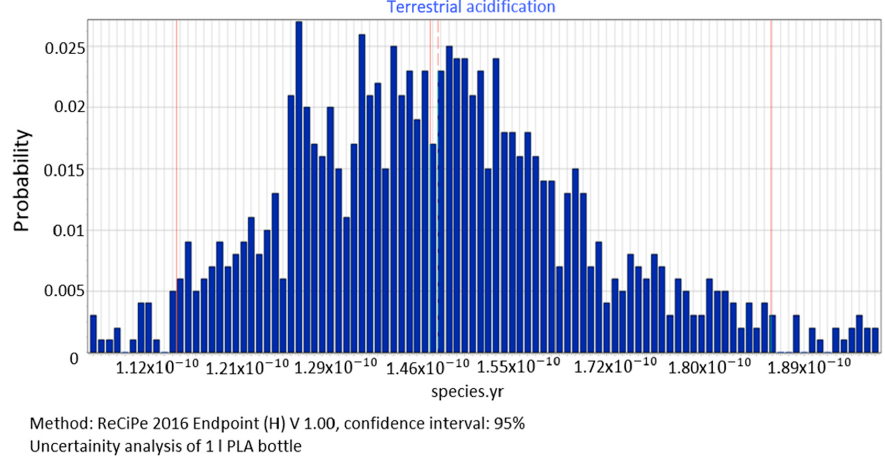
Figure 14. Results of the uncertainty analysis for the category of acidification and its impact on the ecosystem quality. Polymers 2020 , 12 , x FOR PEER REVIEW